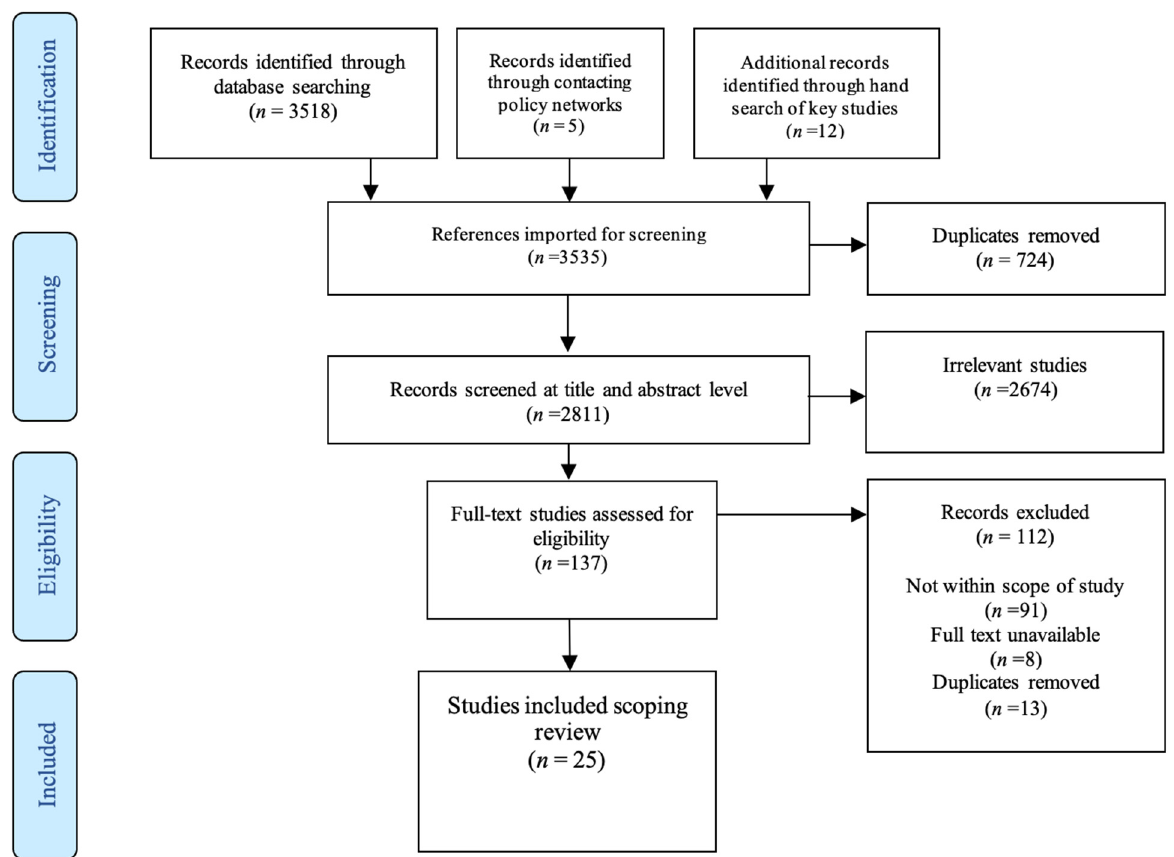
Figure 1. Study selection PRISMA flowchart.